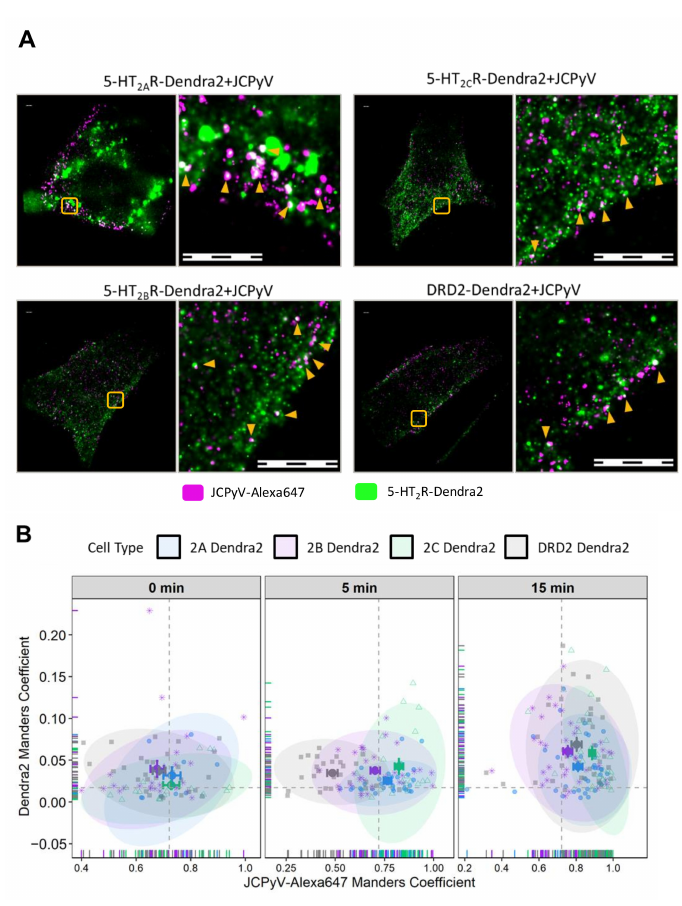
Figure 3. FPALM analysis demonstrates JCPyV localization with 5-HT 2 R-Dendra2 and DRD2- Den- dra2. ( A ) Representative widefield super resolution FPALM images of 5-HT 2A R-Dendra2, 5-HT 2B R- Dendra2, 5-HT 2C R-Dendra2, and DRD2-Dendra2 at 5 min post infection (mpi). Scale bars = 1 µ m. ( B ) Manders’ colocalization coefficients (MCC) demonstrated by scatter plot showing analysis for JCPyV-647 incubated with corresponding 5-HT 2 Rs-Dendra2 and DRD2-Dendra2 stable cells at 0, 5, and 15 mpi. Samples were excited using 561 nm and 638 nm lasers, and activated using a 405 nm laser, and imaged with a 60 × 1.45NA TIRF objective. Normal distribution of the population determined by Shapiro Wilks test and Quantile-Quantile plot. Significance was determined using the pairwise Wilcox test and the Bonferroni method was used for the p -value adjustment. Fluorescence images were pre-processed, and the background signal was removed. MCCs were calculated after rendering molecules by convolving localizations with a normalized 50 nm circle. Cell areas were masked using an automatic algorithm. Populations represent at least 10 cells per time point and sample; representative of three independent replicates. Error bars =